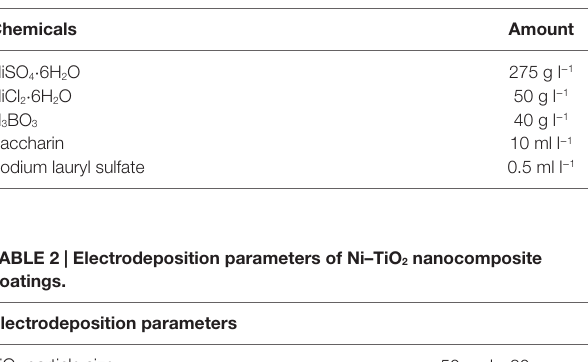
TaBle 1 | composition of Watts bath.